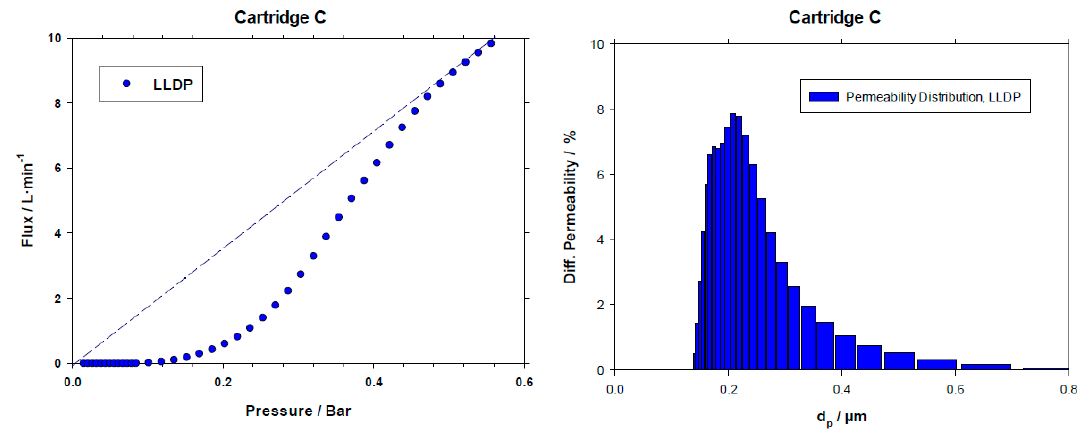
Figure 4. Example of an LLDP porosimetric curve and resulting permeability distribution for the C cartridge.